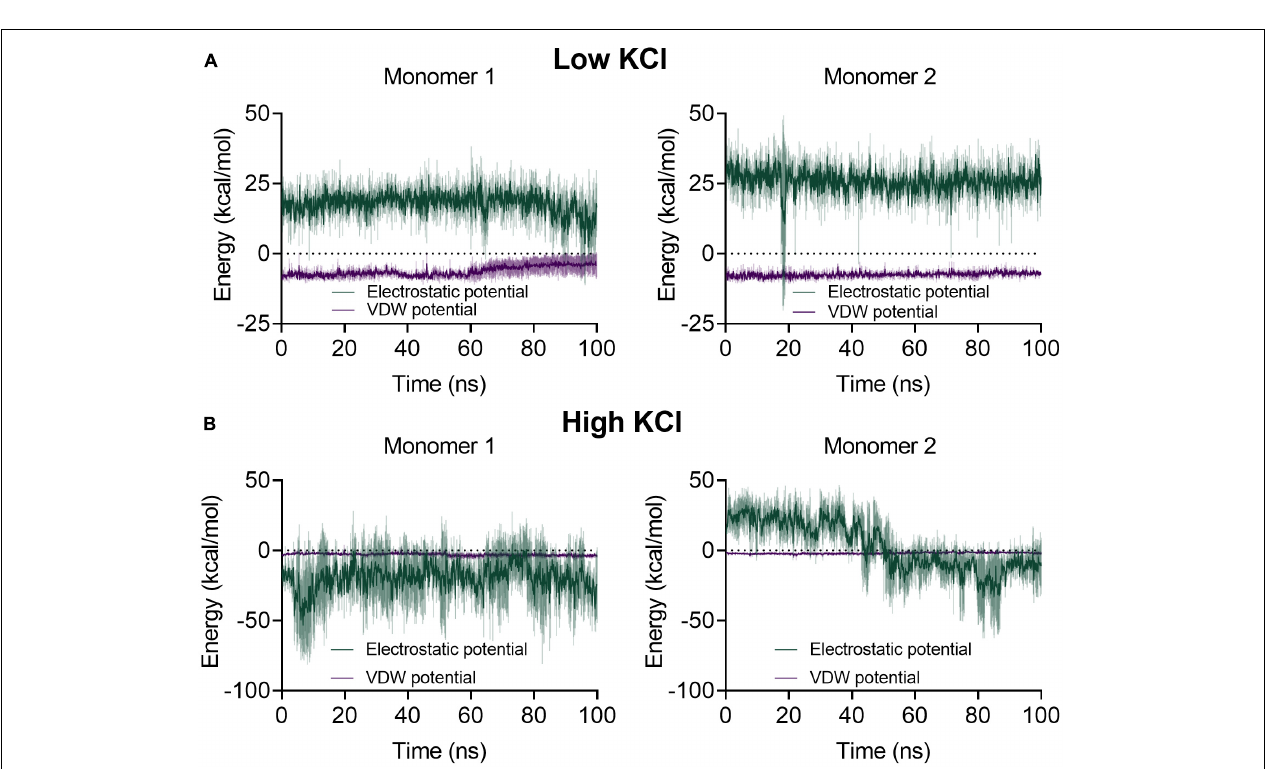
FIGURE 6 | Average electrostatic and van der Waals potential energies between the β 6- α 10 loop and glucose-6-phosphate (G6P) for each monomer at low and high salt concentrations. The colored lines represent the average values of three 100-ns replicates with a 1-kcal/mol Å 2 restriction to G6P and to the hydroxyl group of the catalytic residue Y152; the ± SD is represented as a shaded area. (A) At low salt concentration, the energy profile of both monomers displays an electrostatic repulsion between the loop and G6P and a lower attractive interaction for the Van der Waals potential. (B) During the high salt molecular dynamics, monomer 1 displays an electrostatic attraction between the loop and G6P through most of the dynamic, whereas the loop in monomer 2 begins with an average electrostatic repulsion and then changes to an average attractive interaction.